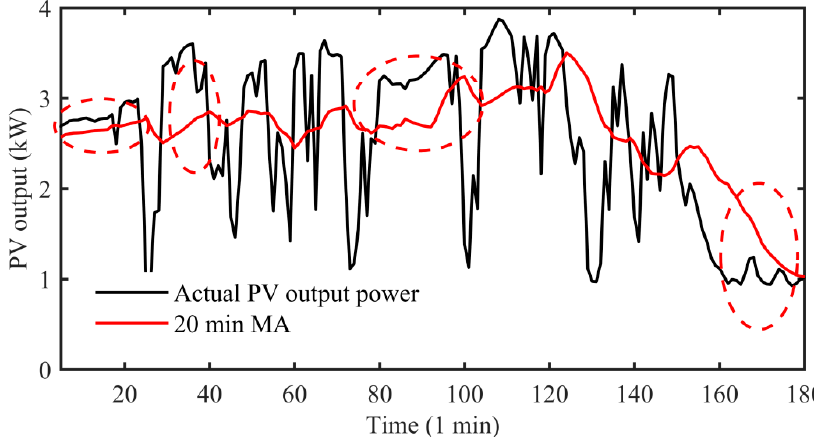
Figure 2. A fluctuating solar energy signal and its 20 min MA counterpart [18].